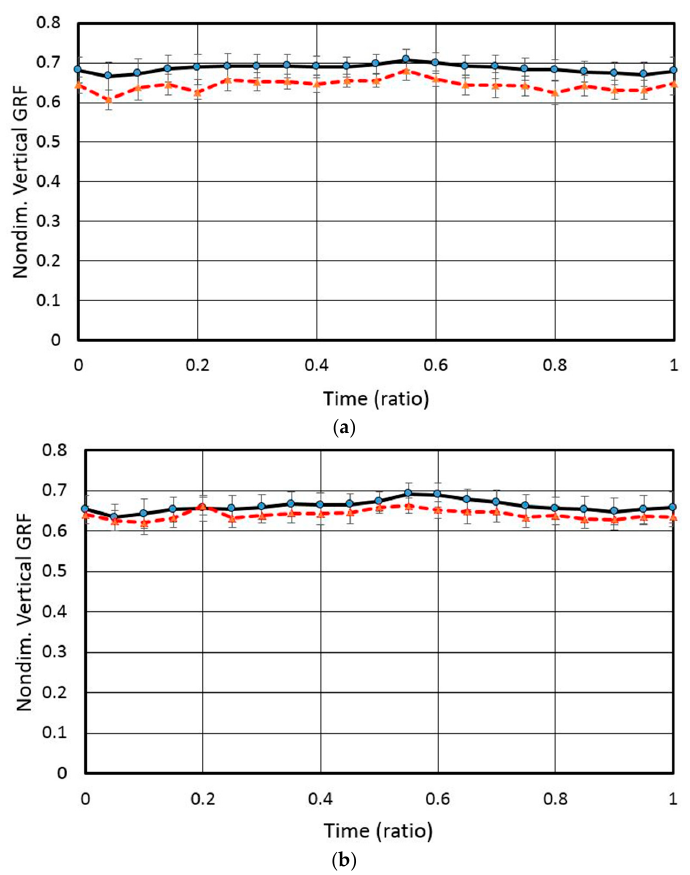
Figure 6. Comparison of measured average normalized vertical GRF with simulated results for the case where the foot position was 0 mm and guide angle was 0° from barbell bar center: ( a ) left vertical GRF and ( b ) right vertical GRF.